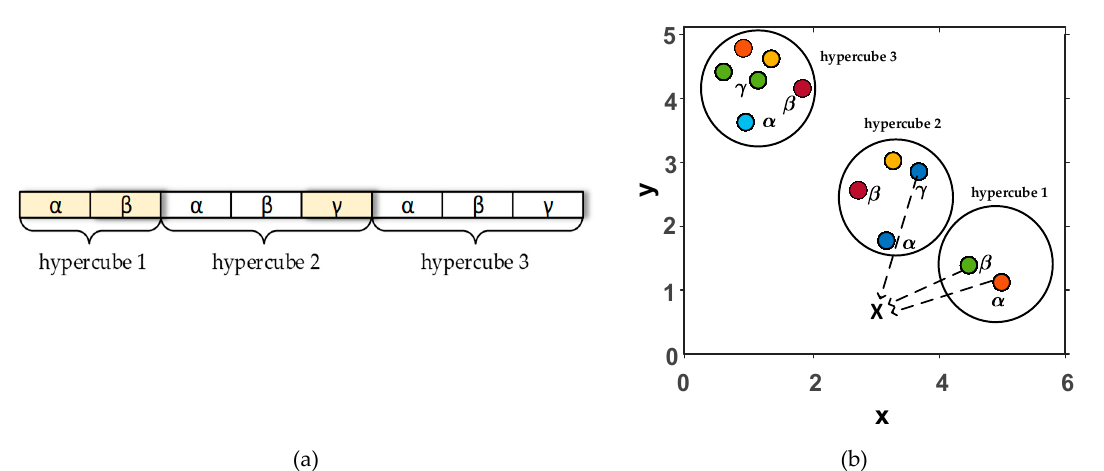
Figure 3. Two modules of MOGWO: ( a ) the archive, which consists of three hypercubes, and ( b ) the leader selection mechanism.